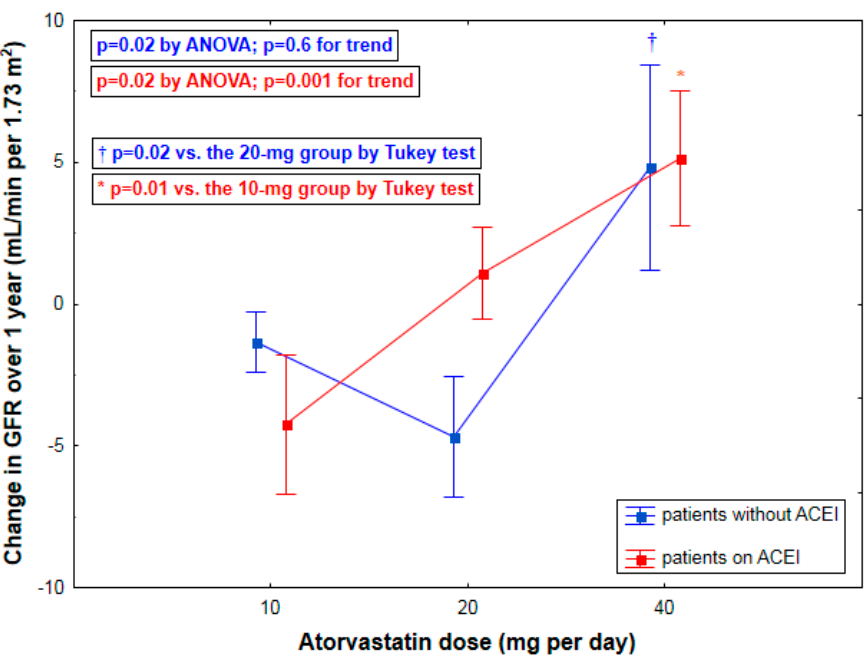
Figure 2. Changes of glomerular filtration rate (GFR) over one year (mean ± SEM) by atorvastatin dosage stratified by the use of angiotensin-converting enzyme inhibitors (ACEI).